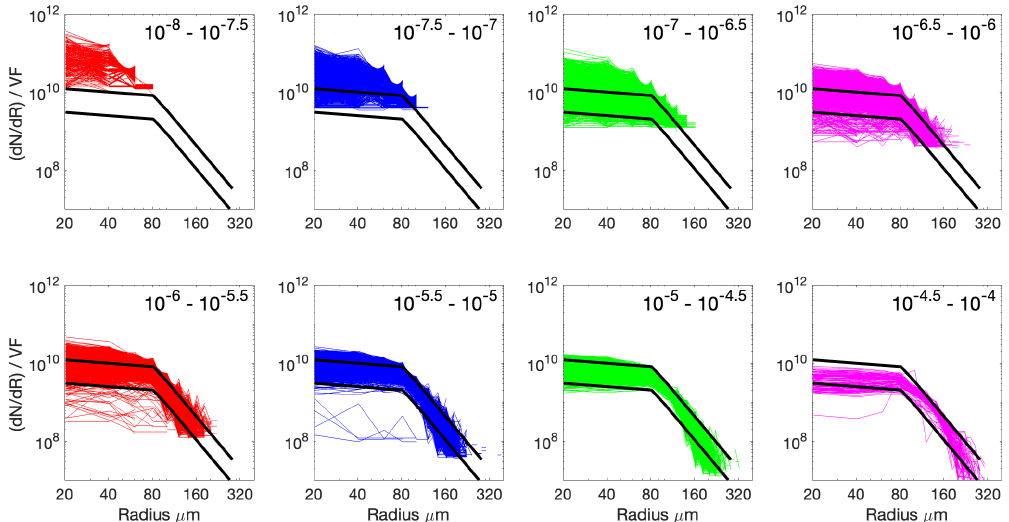
Figure 3. All camera bubble size distributions at 2m depth segregated by void fraction (shown in the top right of each plot) and normalised by the individual void fraction of each distribution (d N / d R ) / VF (m − 3 , µm − 1 ) . The y axis on all plots shows the number of bubbles per micrometre radius increment per unit volume, divided by void fraction. The black lines are the same on all plots and show the halving and doubling of the representative normalised distribution.